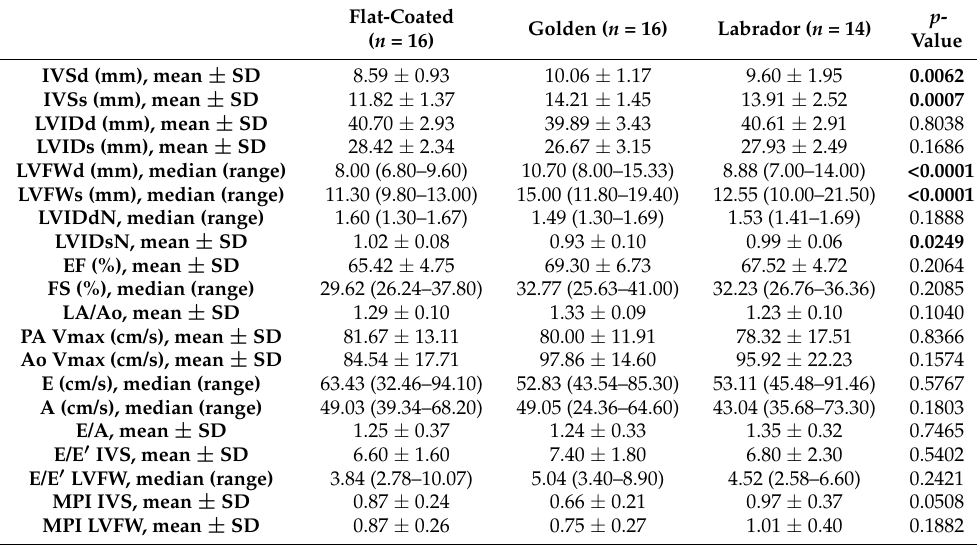
Table 1. Standard echocardiographic parameters of three clinically healthy Retriever breeds.